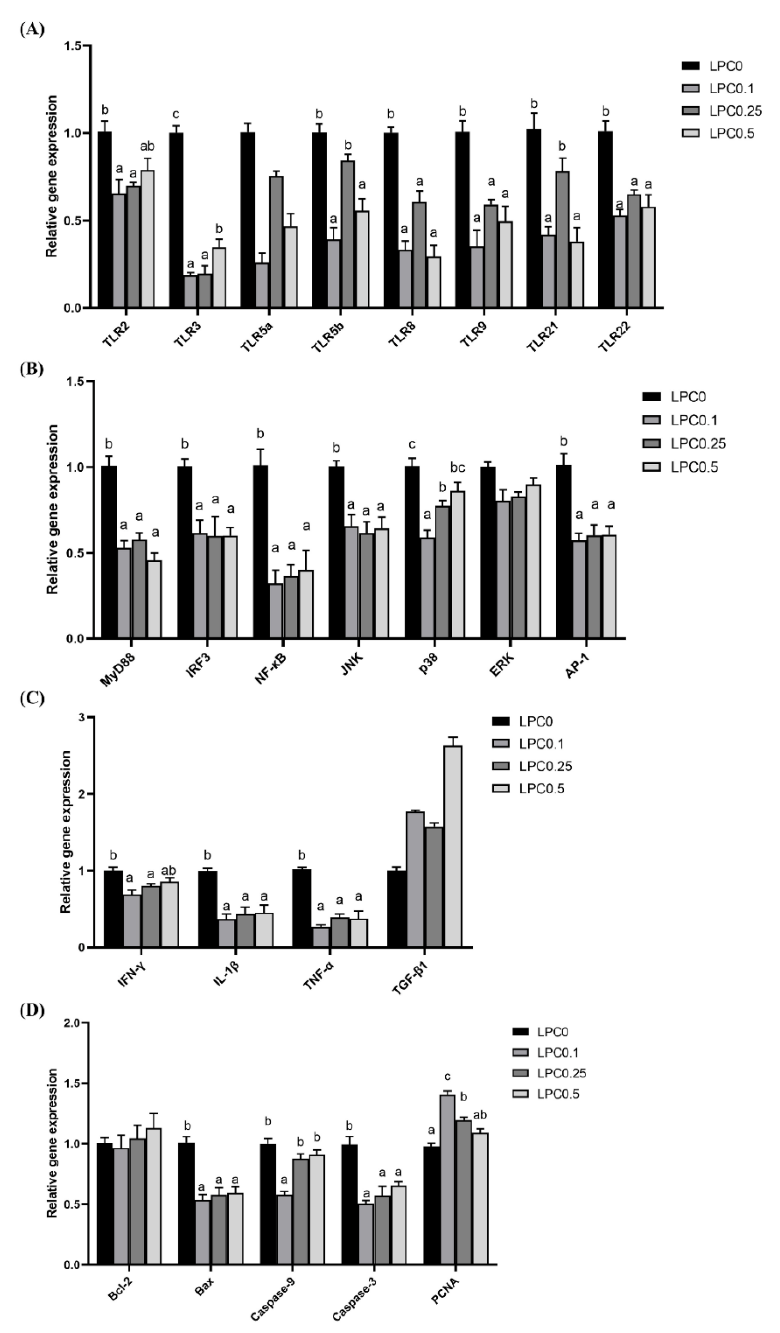
Figure 4. Gene expression of TLR signaling pathway and intestinal mucosal barrier-related factors in the distal intestines ( n = 6). ( A , B ) Gene expression of Toll-like receptors (TLRs), adaptor proteins, and downstream regulator molecules; ( C ) Gene expression of inflammatory cytokines; ( D ) Gene expression of epithelial cell apoptosis and proliferation. Results were expressed as means ± S.E., and different superscript letters indicate significant differences ( p < 0.05).